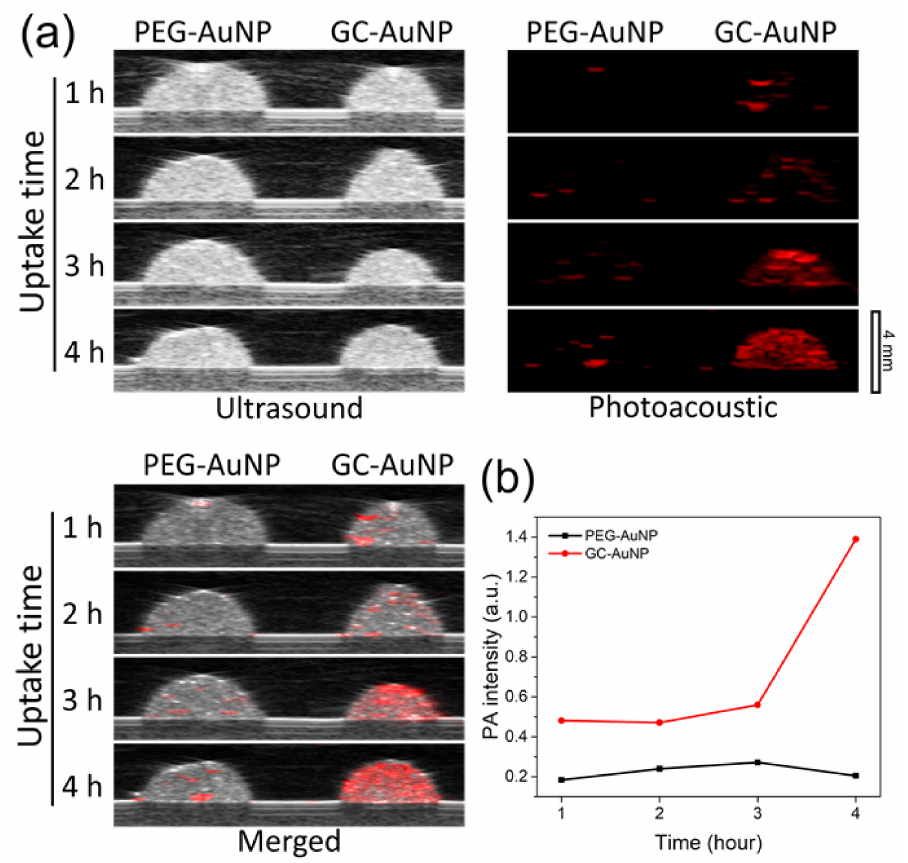
Figure 3. ( a ) Ultrasound (left), photoacoustic (middle), and merged (right) images of macrophage (J774.A1) cell phantoms that were produced after incubation with gold nanoparticles for 1 h, 2 h, 3 h, and 4 h (from the top to the bottom). Each cell phantom contained approx. 13 × 10 5 cells with the dimension of 4 mm × 4 mm × 2 mm (~15 mm 3 ). In PA images, excitation laser wavelength was 680 nm and laser power 0.62 mJ; ( b ) Averaged photoacoustic signal intensity in the cell phantom region according to cellular uptake